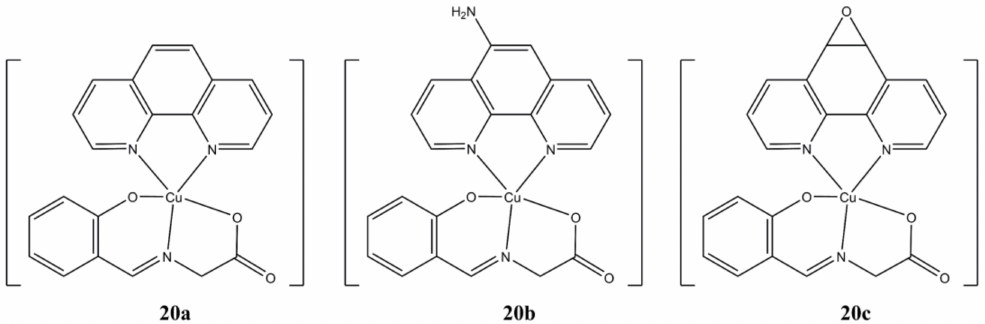
Figure 20. Structures of the [Cu(Sal-Gly)(N-N 4 )] complexes. The complexes show dose and time-dependent micromolar cytotoxicity towards cancerous (A-549, HCT-116, HeLa, MBA-MB-231 and SHSY5Y) cells, while generally being less active against healthy HASMC1 and HASMC2 cells. Compound 20b appears to be the most promising in terms of both anticancer potency and selectivity. Rapid apoptotic cell death in HCT-116 and HeLa cells was detected with induction of ROS production, depolarization of mitochondrial membrane, depletion of GSH and cellular DNA damage ( γ -H2AX expression). Interestingly, gene-knockdown experiments on HeLa cells